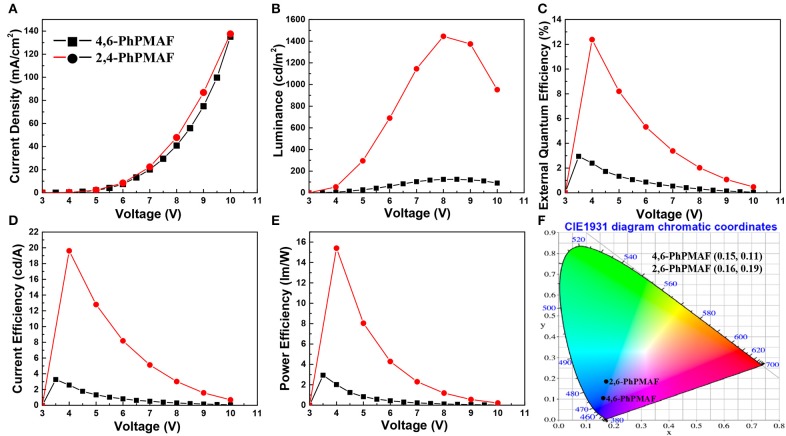
Graph of (A) current density, (B) luminance, (C) external quantum efficiency, (D) current efficiency, and (E) power efficiency as a function of applied voltage of devices with emitting materials and (F) CIE coordinate of devices based on CIE 1931.